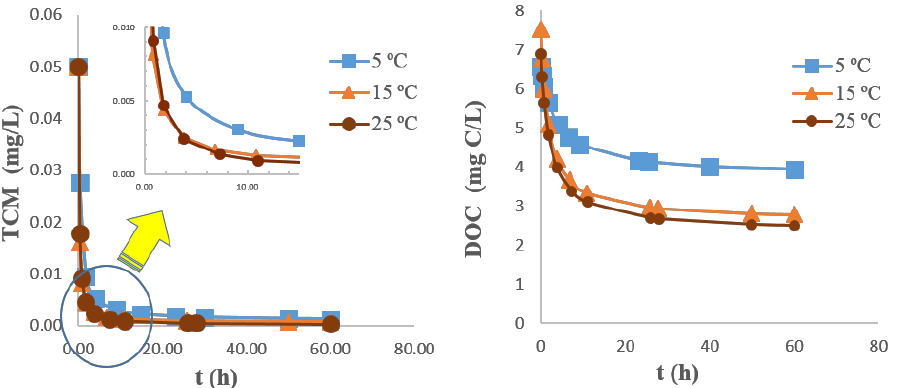
Figure 6. Variation in TCM and DOC concentration with time of raw water, obtained for the para- metric analysis of GAC sorption capacity at 1.5 g/L concentrations of GAC and three